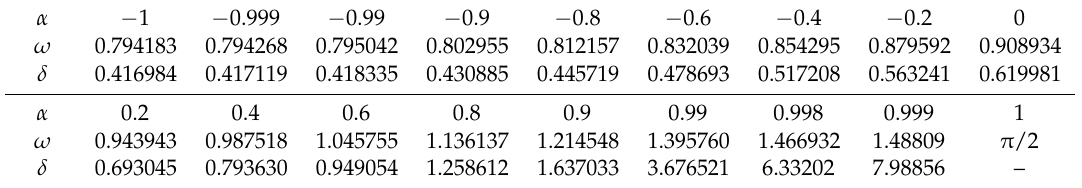
Table 2. Selected values of ω (in radians) and δ on varying α for materials with β =